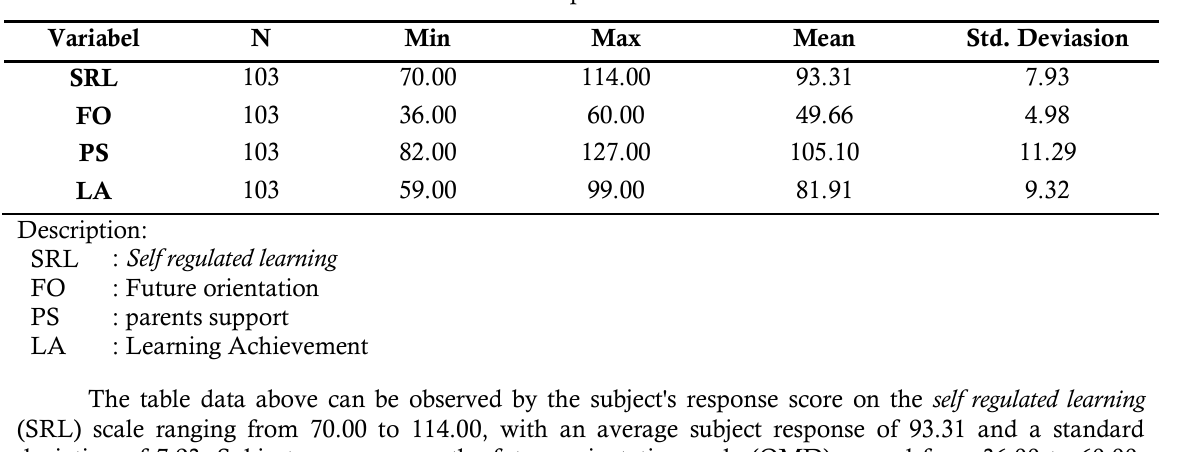
Table 2. The description of research